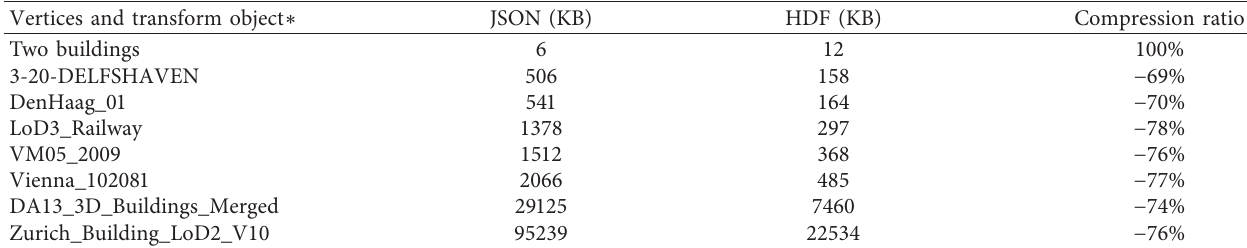
Table 2: Storage cost for vertices and transform objects in JSON and HDF.